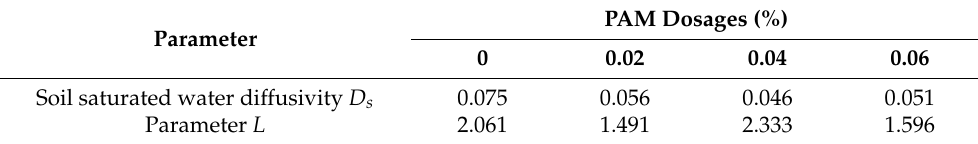
Table 5. Soil saturated water diffusivity D s and parameter L under different PAM dosages.